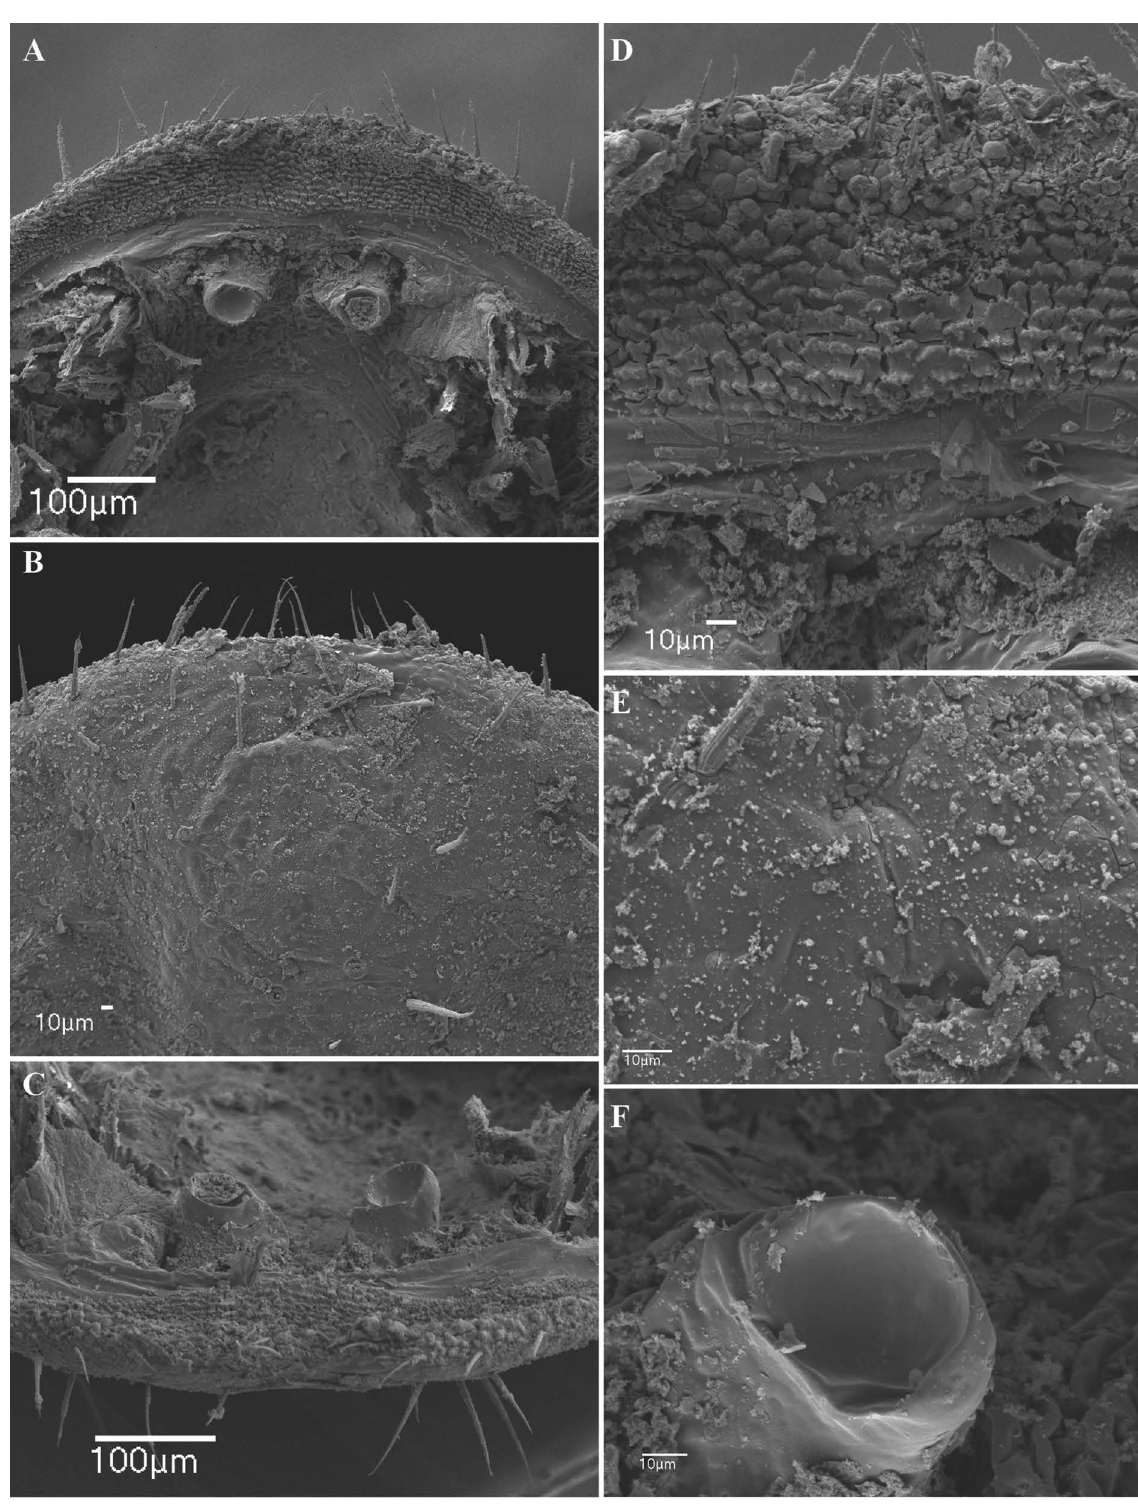
Fig. 106. Sarax bilua sp. nov. (AMCC [LP 5564]), female gonopod and genital operculum. A . Plunger- like gonopod, dorsal view. B . Posterior margin of genital operculum, ventral view. C . Gonopods, posterior view. D . Genital operculum between gonopods. E . Glandular openings on margin of genital operculum. F . Inside gonopod